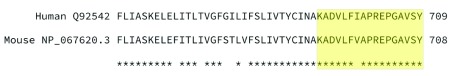
Human / mouse nicastrin alignment.Shown is a partial alignment between human and mouse nicastrin. The highlighted area represents the peptides use for generation of the polyclonal antibody. Asterisks represent a matching amino acid between the two sequences, and spaces are mismatches.